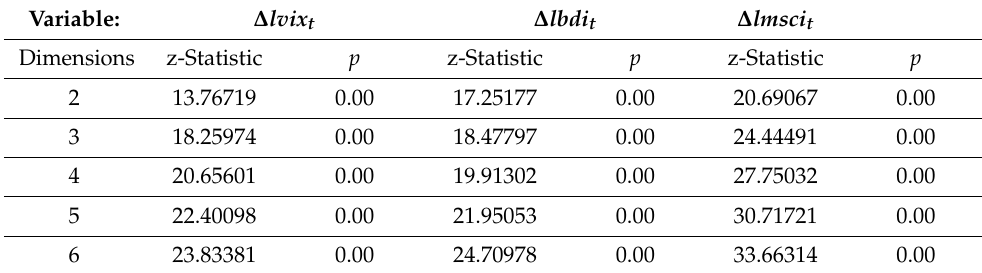
Table 3. BDS Test